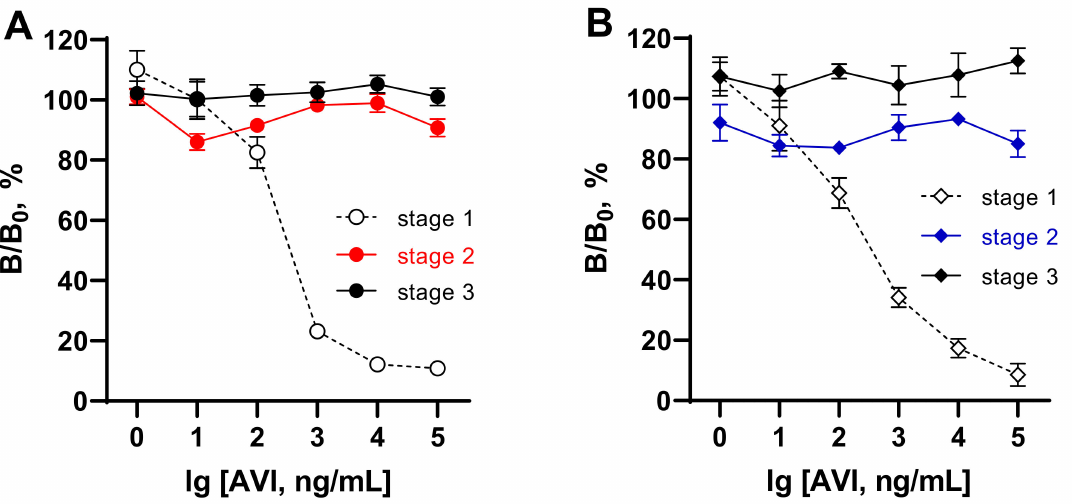
Figure 4. Influence of extraneous AVI on different stages of ELISAs for bacitracin ( A ) and colistin ( B ) based on coated complexes formed between SAV and biotinylated hapten. Complex formation between coated SAV and BT/COL–B 7 (stage 1), antibody–analyte binding (stage 2), and bound antibody–GAR–HRP interaction (stage